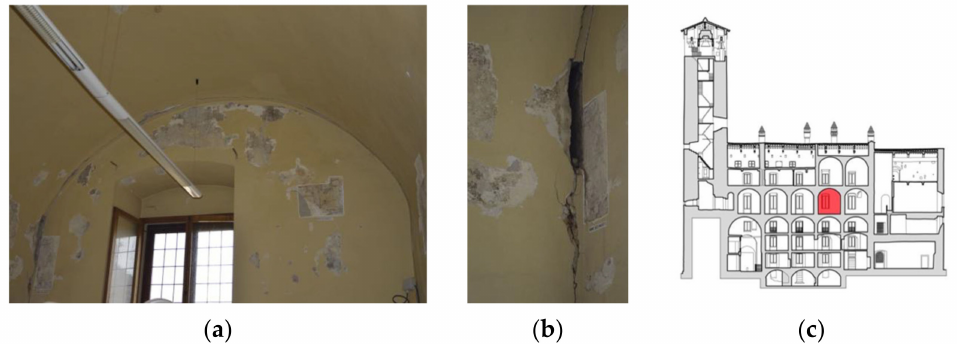
Figure 16. ( a,b ) Post-earthquake damage pattern; ( c ) identification of the examined